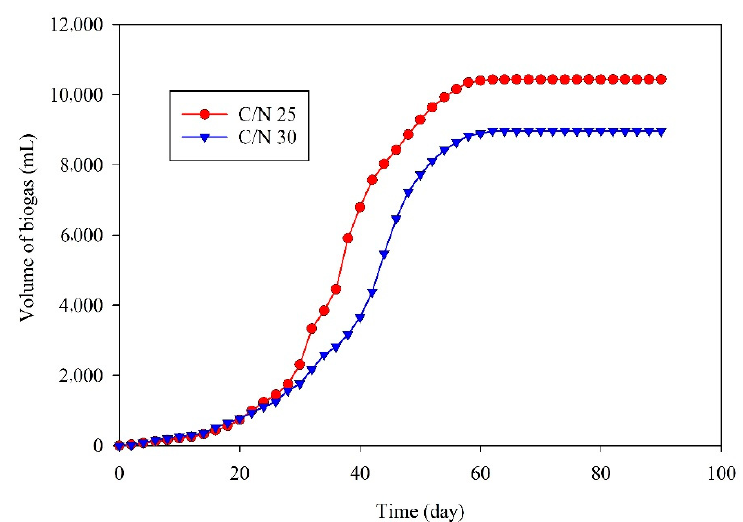
Figure 8. Effect of different C/N ratios on the accumulation of 25% total solids (TS) biogas with delignification.